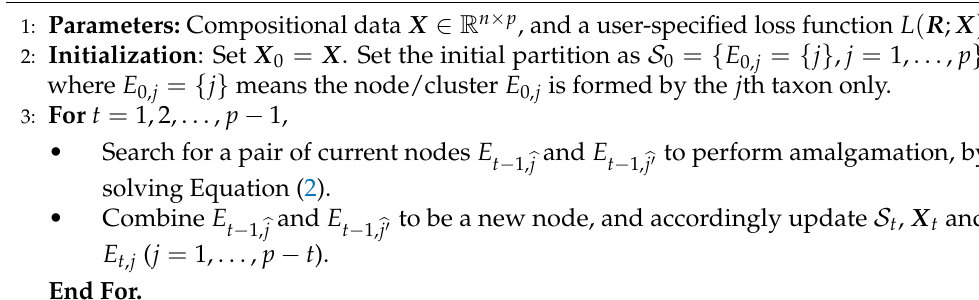
Algorithm 1 Hierarchical principal amalgamation analysis (HPAA) via agglomerative